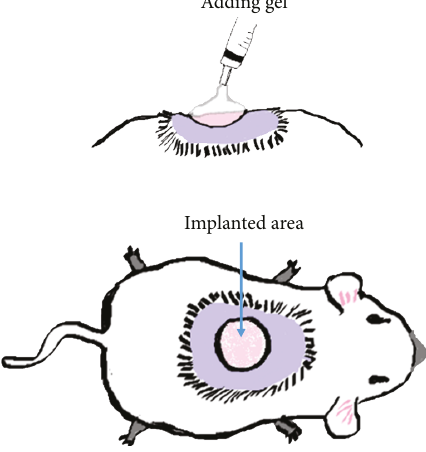
Figure 1: Cartoon depicting a surgical model for the in vivo